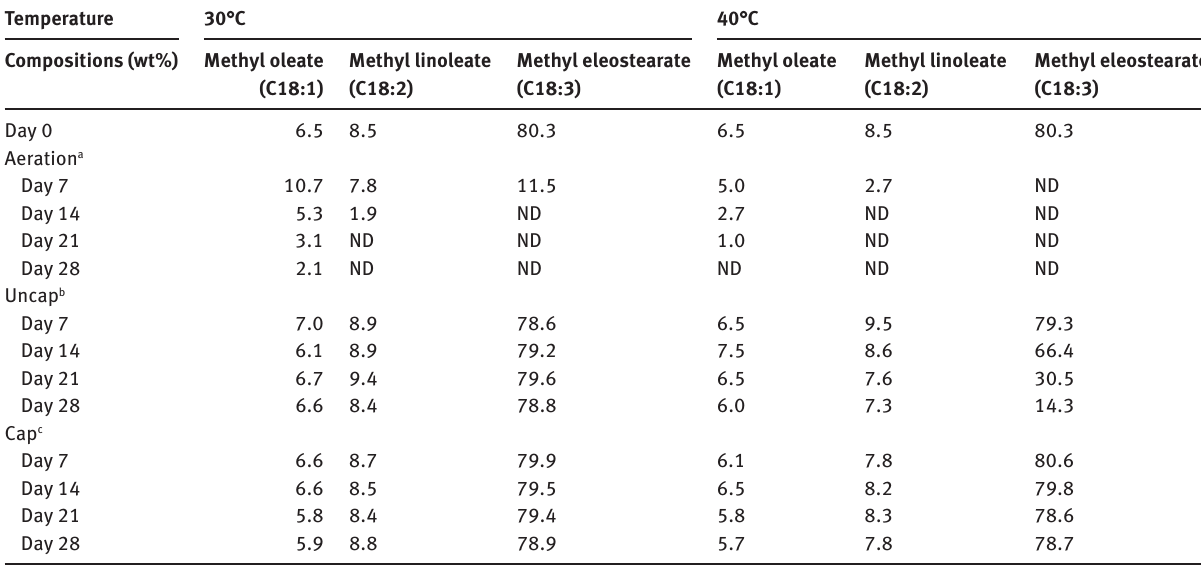
Table 3: Variation in the unsaturated ester content of VMO BDF during 4 weeks of storage at 30 ° C and 40 °